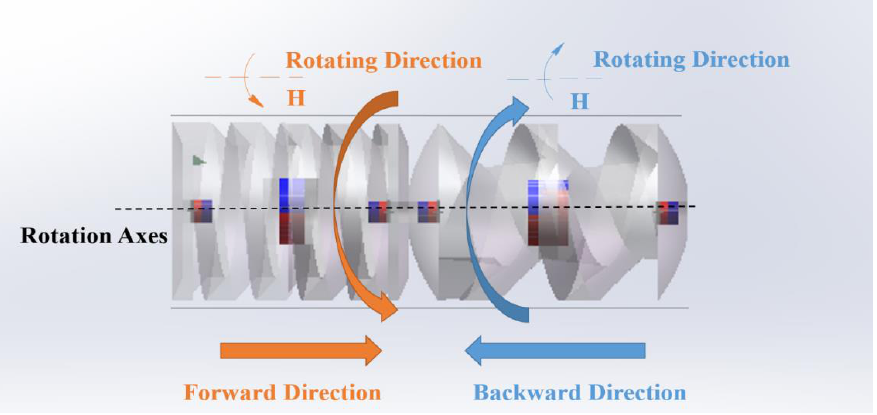
Figure 3. Motion mechanism of the active locomotion.